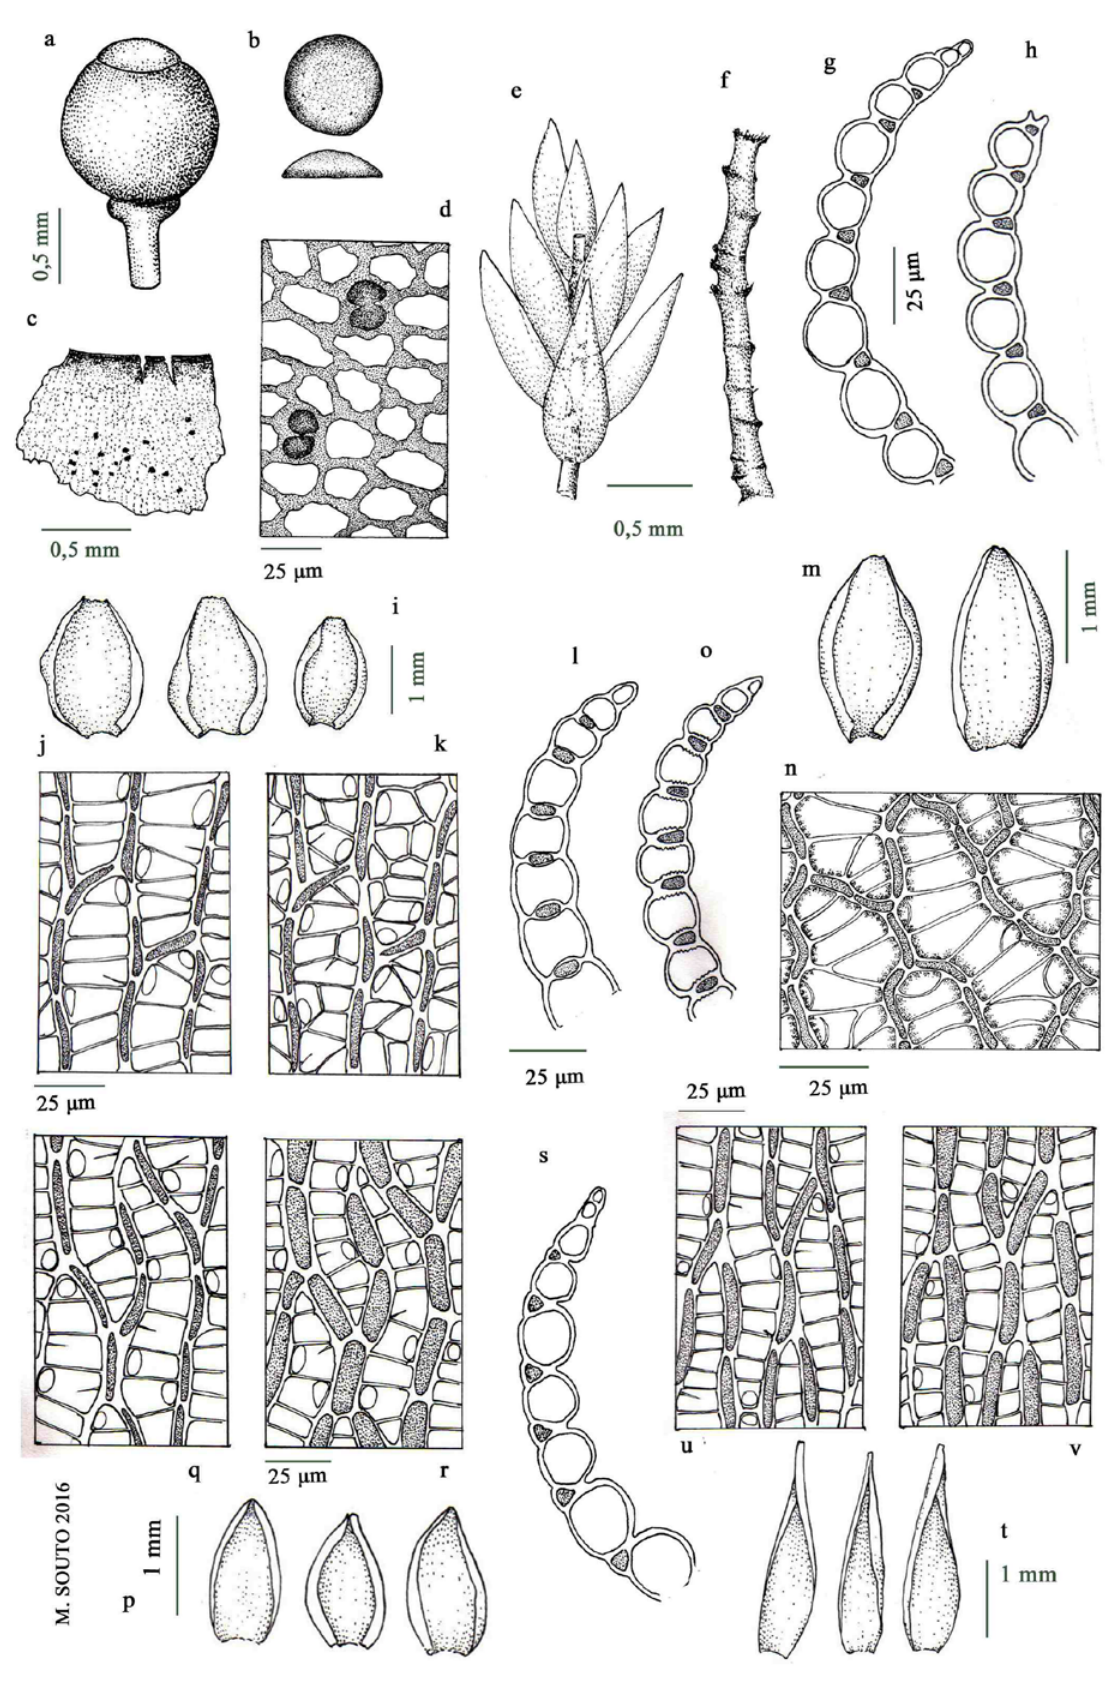
Figure A2. Sphagnum . For legend, see next